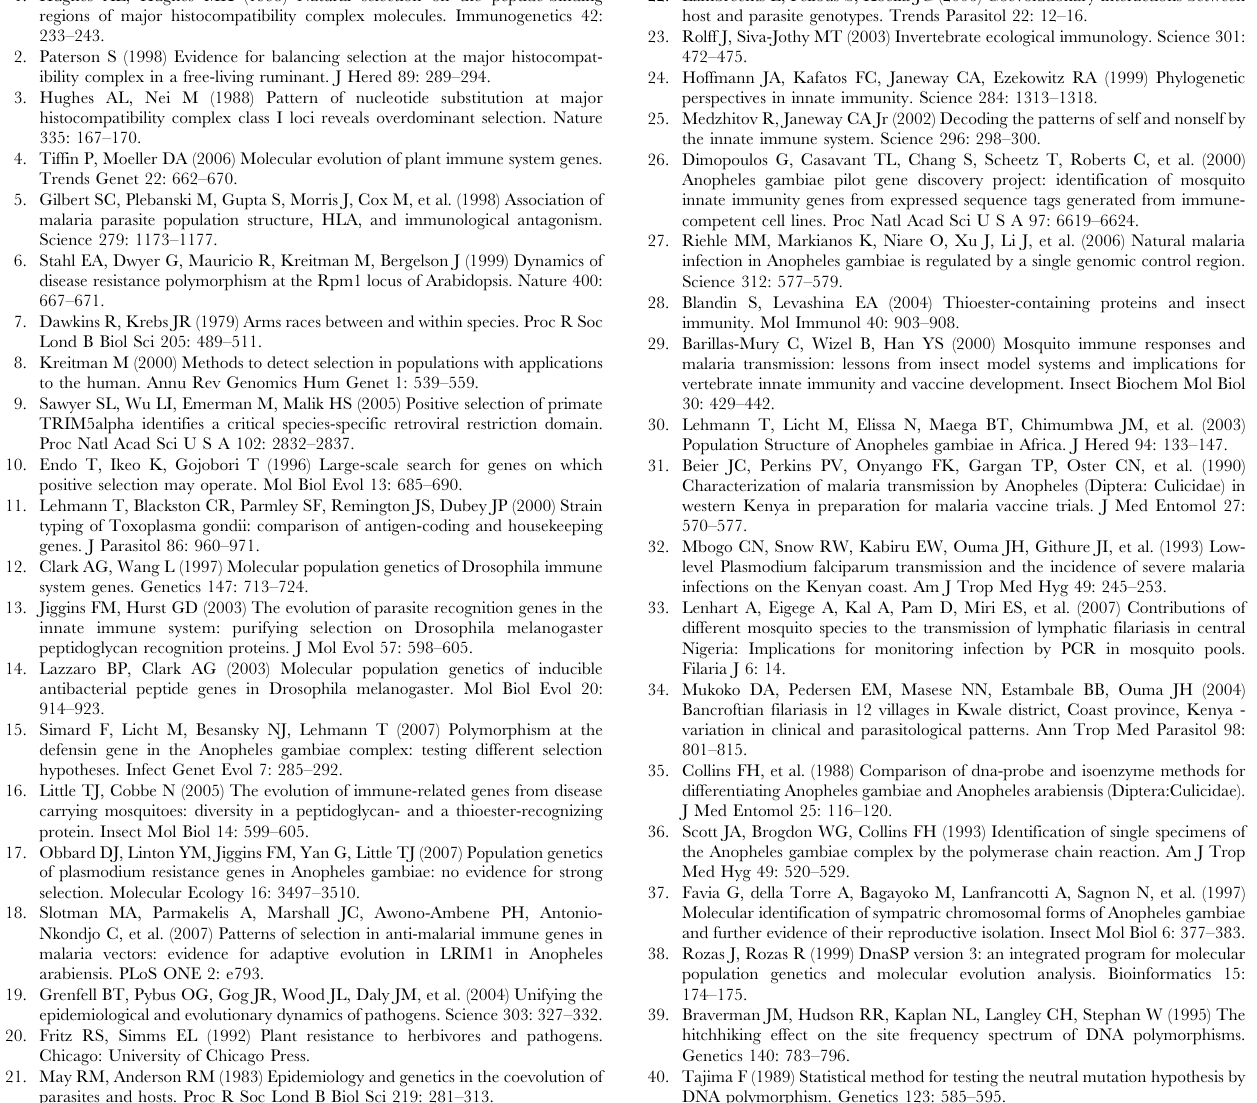
Figure S4 Alignment of polymorphic positions in GNBP after exclusion of all gaps (indels). Dots indicate identity with corresponding base of the first sequence. Position number is indicated above each base and species affiliation on the left of each sequence. Silent changes in coding regions are highlighted in gray and amino acid replacement changes are highlighted in red Found at: doi:10.1371/journal.pone.0004549.s005 (0.38 MB